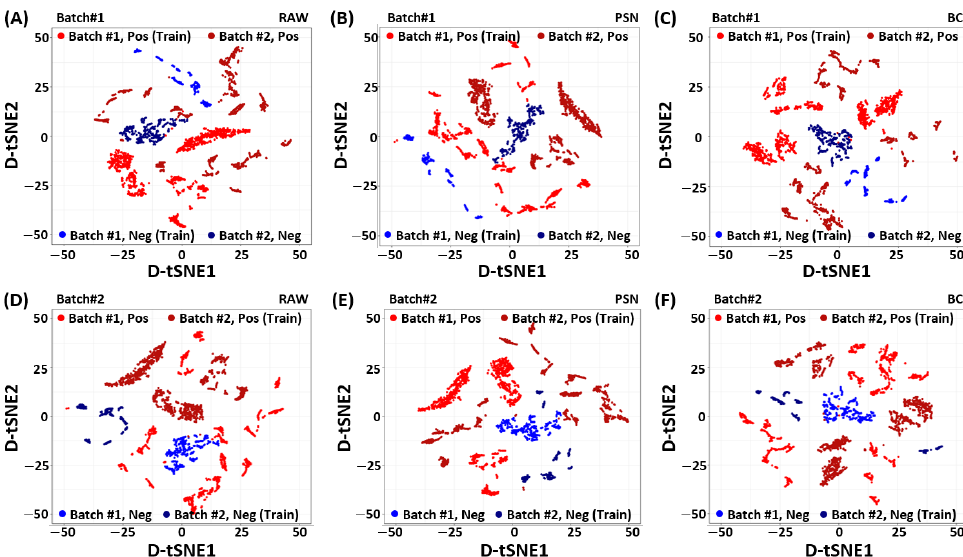
Figure 2. Visualization of the Density preserving t-SNE ( D-tSNE ) embedding of the Pb(NO 3 ) 2 SERS spectrum for ( A , D ) RAW, ( B , E ) Power Spectrum Density Normalization (PSN), and ( C , F ) Baseline Correction (BC) methods. The PCA embedding is learned with the 80% training dataset of one batch. The dataset of the other batch is projected using the learned PCA embedding. The D-tSNE is used as the dimension reduction technique to reduce the dimension of the projected dataset while keeping spreading of the data points. Top: Batch1. Bottom: batch2. Left: RAW. Middle: PSN. Right: